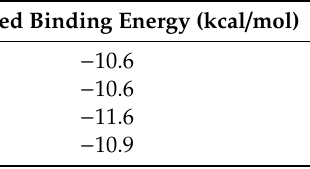
Figure 4. The h BuChE active site in complex with ( R )- 13 (in salmon, A , B ) and ( S )- 13 (in purple, C , D ) pseudo -enantiomers. All the amino acids exhibiting in the vicinity of the ligands up-to 6.0 Å are rendered. Hydrogen atoms of amino acids are omitted for clarity. Catalytic triad residues are shown in yellow, and amino acid residues in blue ( A , C ). In 2D diagrams ( B , D ), crucial amino acid residues are displayed in di ff erent colours depending on the nature of the interaction (e.g., purple for π - π , orange for anion- π , dark green for van der Waals contact, and light green for conventional hydrogen bond). Table 3. The best obtained calculated binding energies with Autodock Vina software for the carltonine derivatives under the in silico study within h BuChE